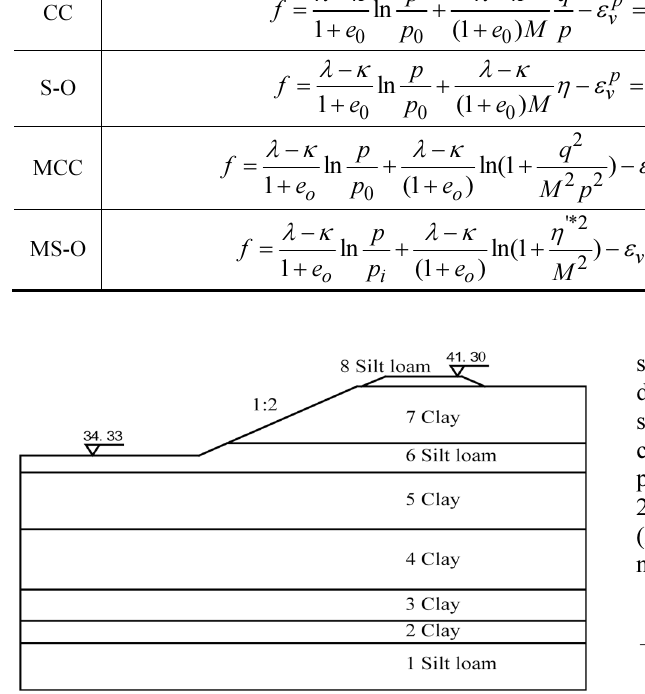
Table 1. Yield function comparison of four models Yield function Shape of the yield locus